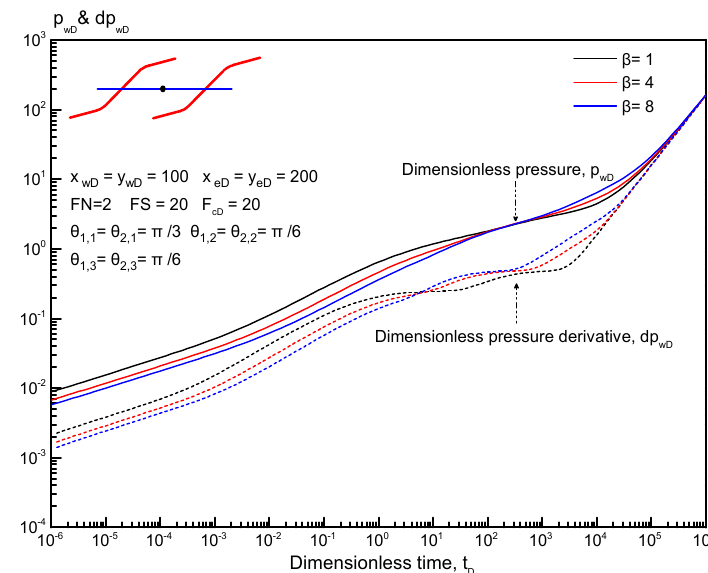
Energies 2019 , 12 , x FOR PEER REVIEW 15 of 23